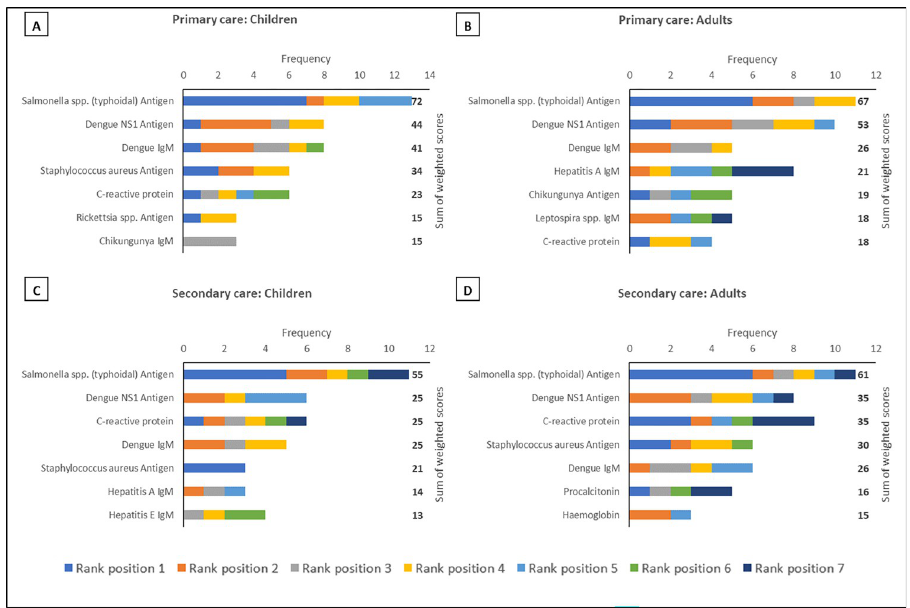
Fig 3. The top seven analytes, in descending order of priority based on sum of weighted scores, which should be considered for inclusion in multiplex lateral flow rapid diagnostic tests for acute non-malarial fever using fingerprick blood as the test substrate, in the following patient populations in South Asia: (A) Children presenting to primary care settings (B) Adults presenting to primary care settings (C) Children being admitted to secondary care settings (D) Adults being admitted to secondary care settings. Children were defined as patients aged > 28 days and < 15 years. An analyte in rank position 1 was weighted seven times more than an analyte in rank position 7; the maximum sum of weighted scores per analyte was